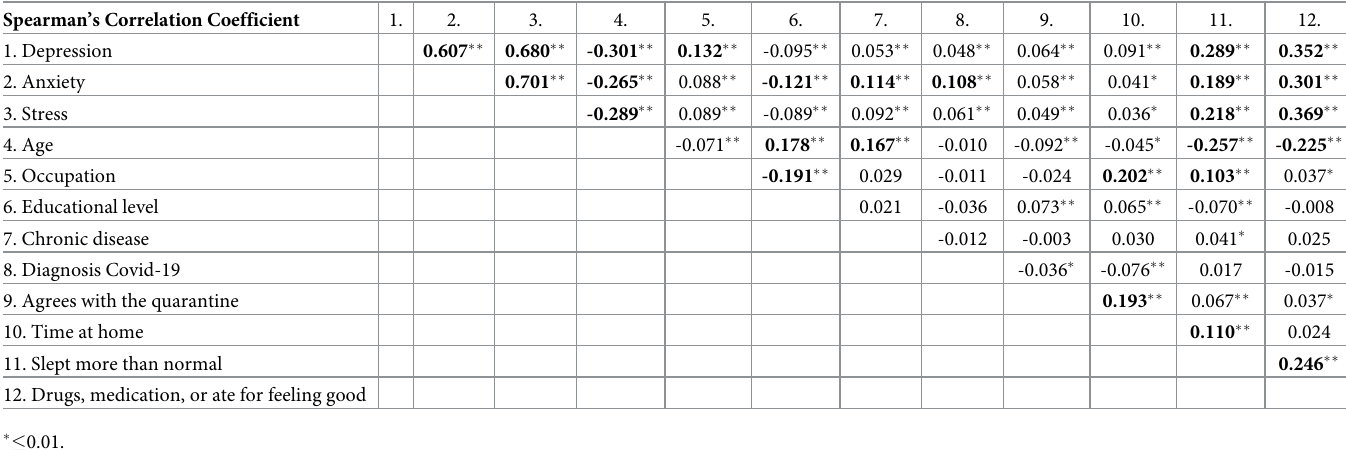
Table 6. Correlation of among sociodemographic variable, coping strategies, depression, anxiety, and stress (N = 3000). Spearman’s Correlation